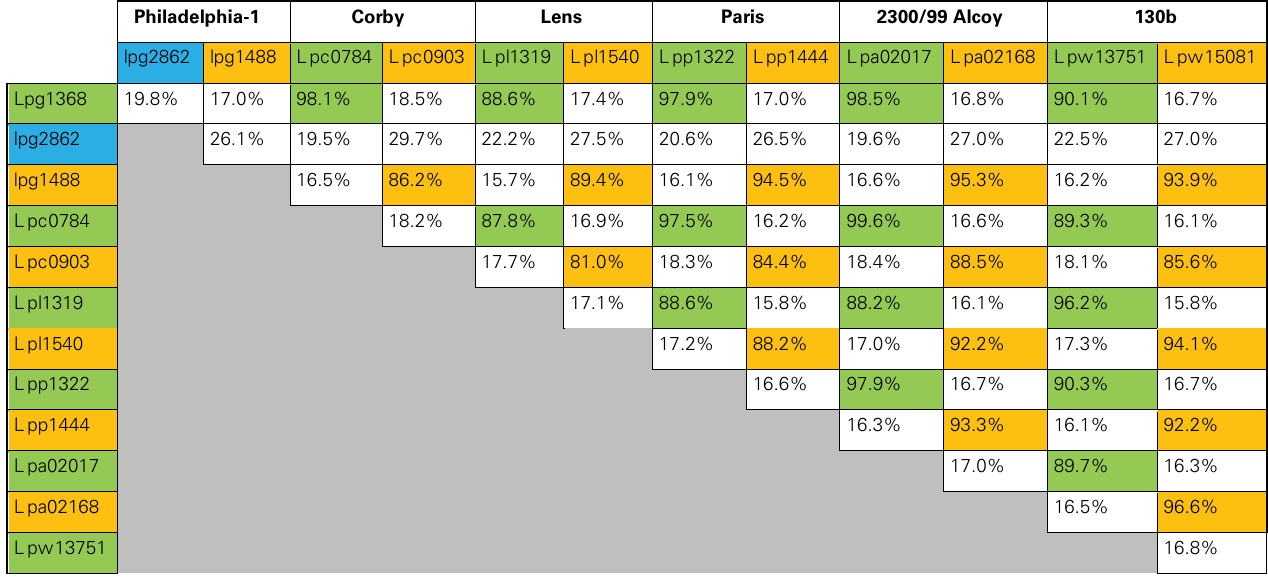
Table 2 | Amino acid sequence identity of proteins of the Lgt-family of L. pneumophila (Philadelphia-1, Corby, Lens, Paris, 2300/99 Alcoy, and 130b) . Proteins belonging to Lgt1, Lgt2, or Lgt3 groups were cross-aligned pair-wise to determine the degree of identical amino acid residues. The homology is shown as a percentage of identical amino acid residues. Lgt1-group glucosyltransferases are marked by green, Lgt2 – by blue, and Lgt3 – by yellow color.